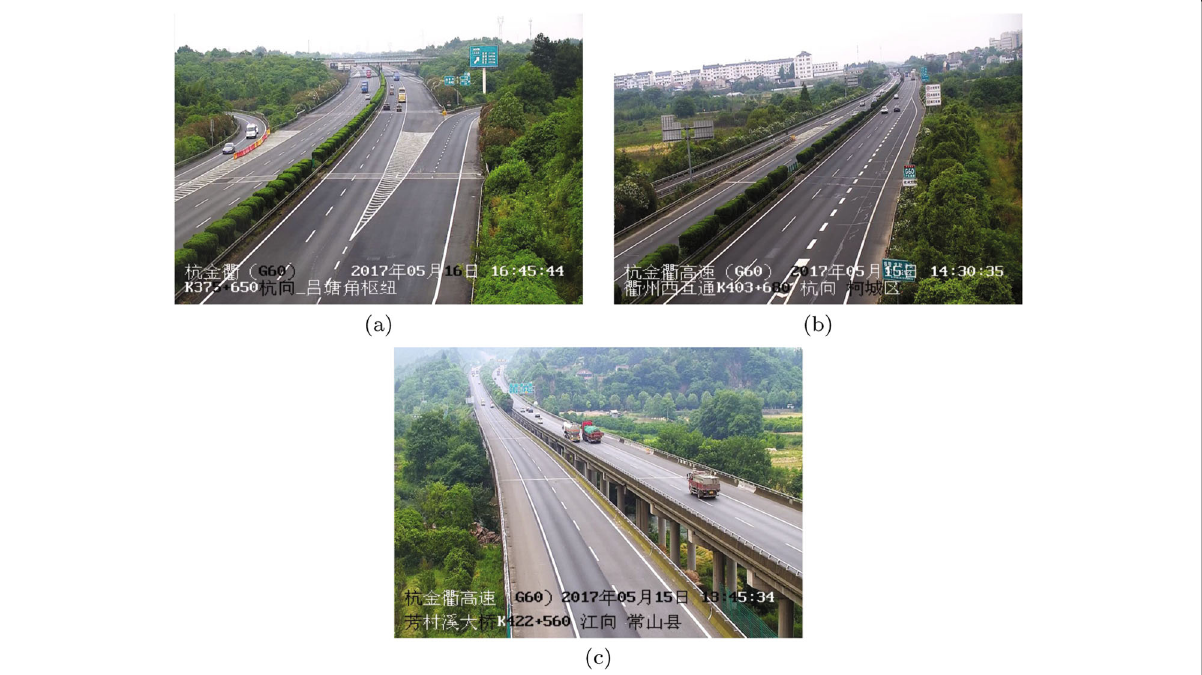
Fig. 1 Scenes taken by multiple highway surveillance cameras. a Scene 1; b Scene 2; c Scene